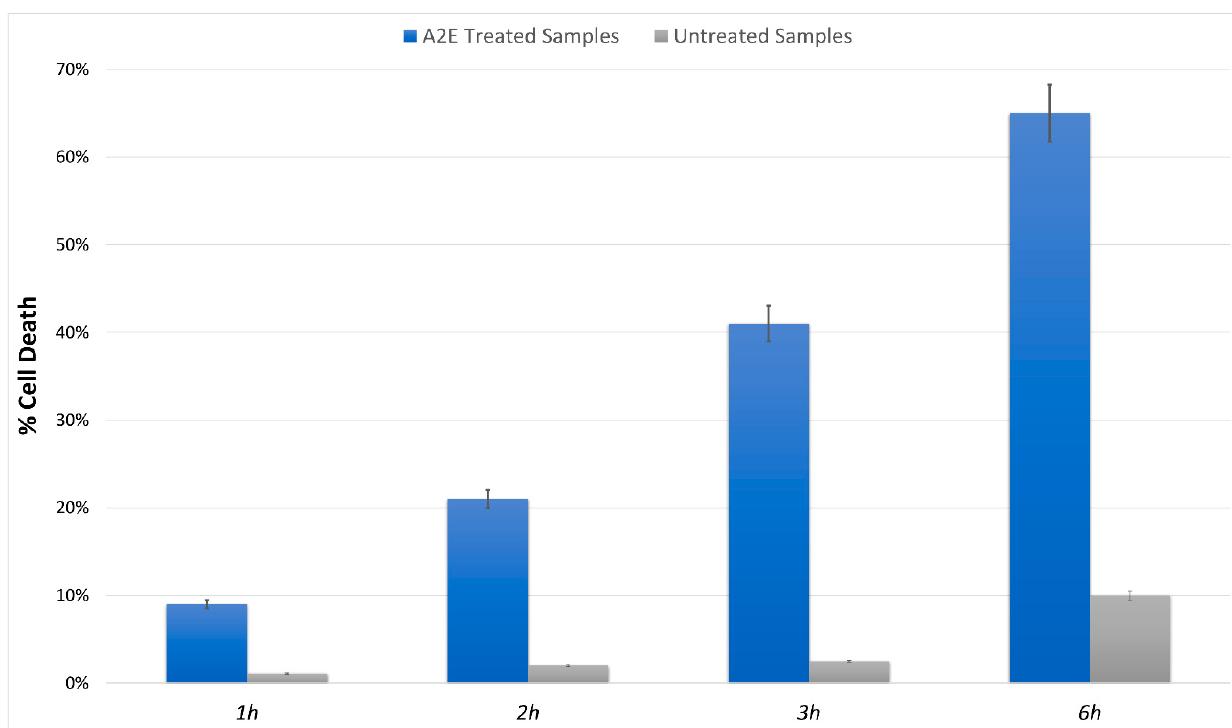
Figure 1. MTT determination of A2E treatment in RPE cells. Cell death was assessed at evaluated time points (1 h, 2 h, 3 h and 6 h) in A2E stressed samples (blue bars) compared to basal untreated group (grey bars). Results are shown as mean ± standard error of mean (n = 3). p -value < 0.05.